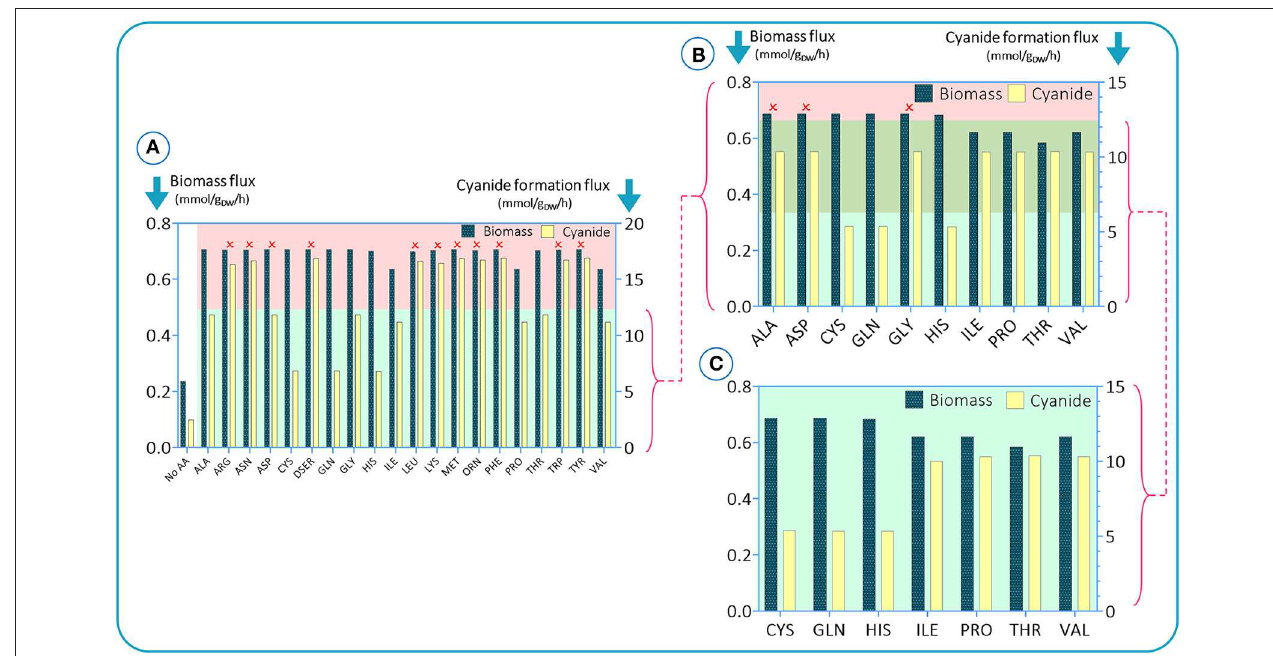
FIGURE 2 | In silico results for studying the impacts of amino acid elimination on bacterial growth behavior and cyanide production. In each simulation, a single amino acid is omitted. Simulations were conducted in three steps (A–C) . In e. In each step, the amino acids with the highest impacts were selected for the next